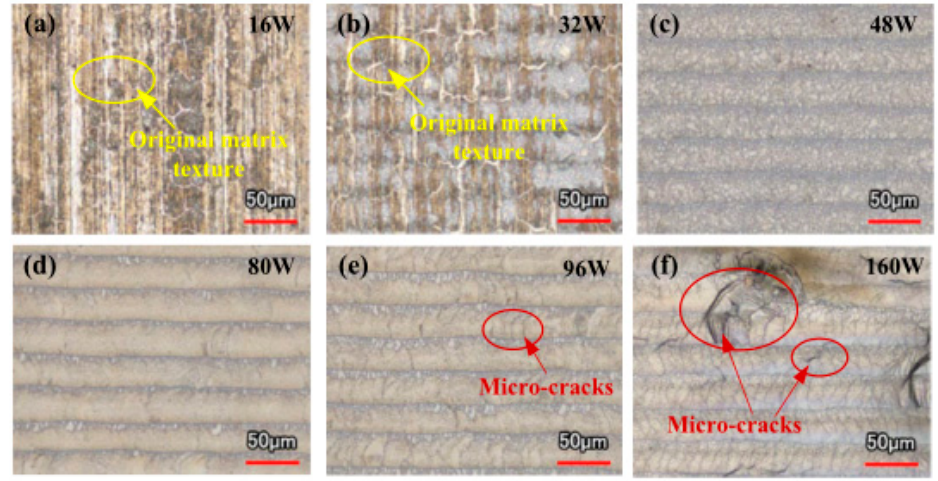
Figure 2. Morphology of laser-cleaned 7075 aluminum alloy with different laser powers [50]. ( a ) 16 W; ( b ) 32 W; ( c ) 48 W; ( d ) 80 W; ( e ) 96 W; ( f ) 160 W.